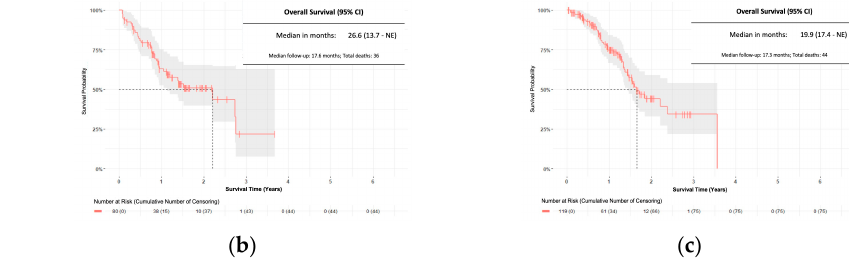
Figure 4. Overall survival: ( a ) 1st ‐ line gefitinib cohort (N = 457); ( b ) 1st ‐ line afatinib cohort (N = 80); ( c ) Post ‐ EGFR ‐ TKI osimertinib cohort (N = 119). Abbreviations: 95% CI: 95% confidence interval. The grey area around the curves represents the 95% confidence intervals.